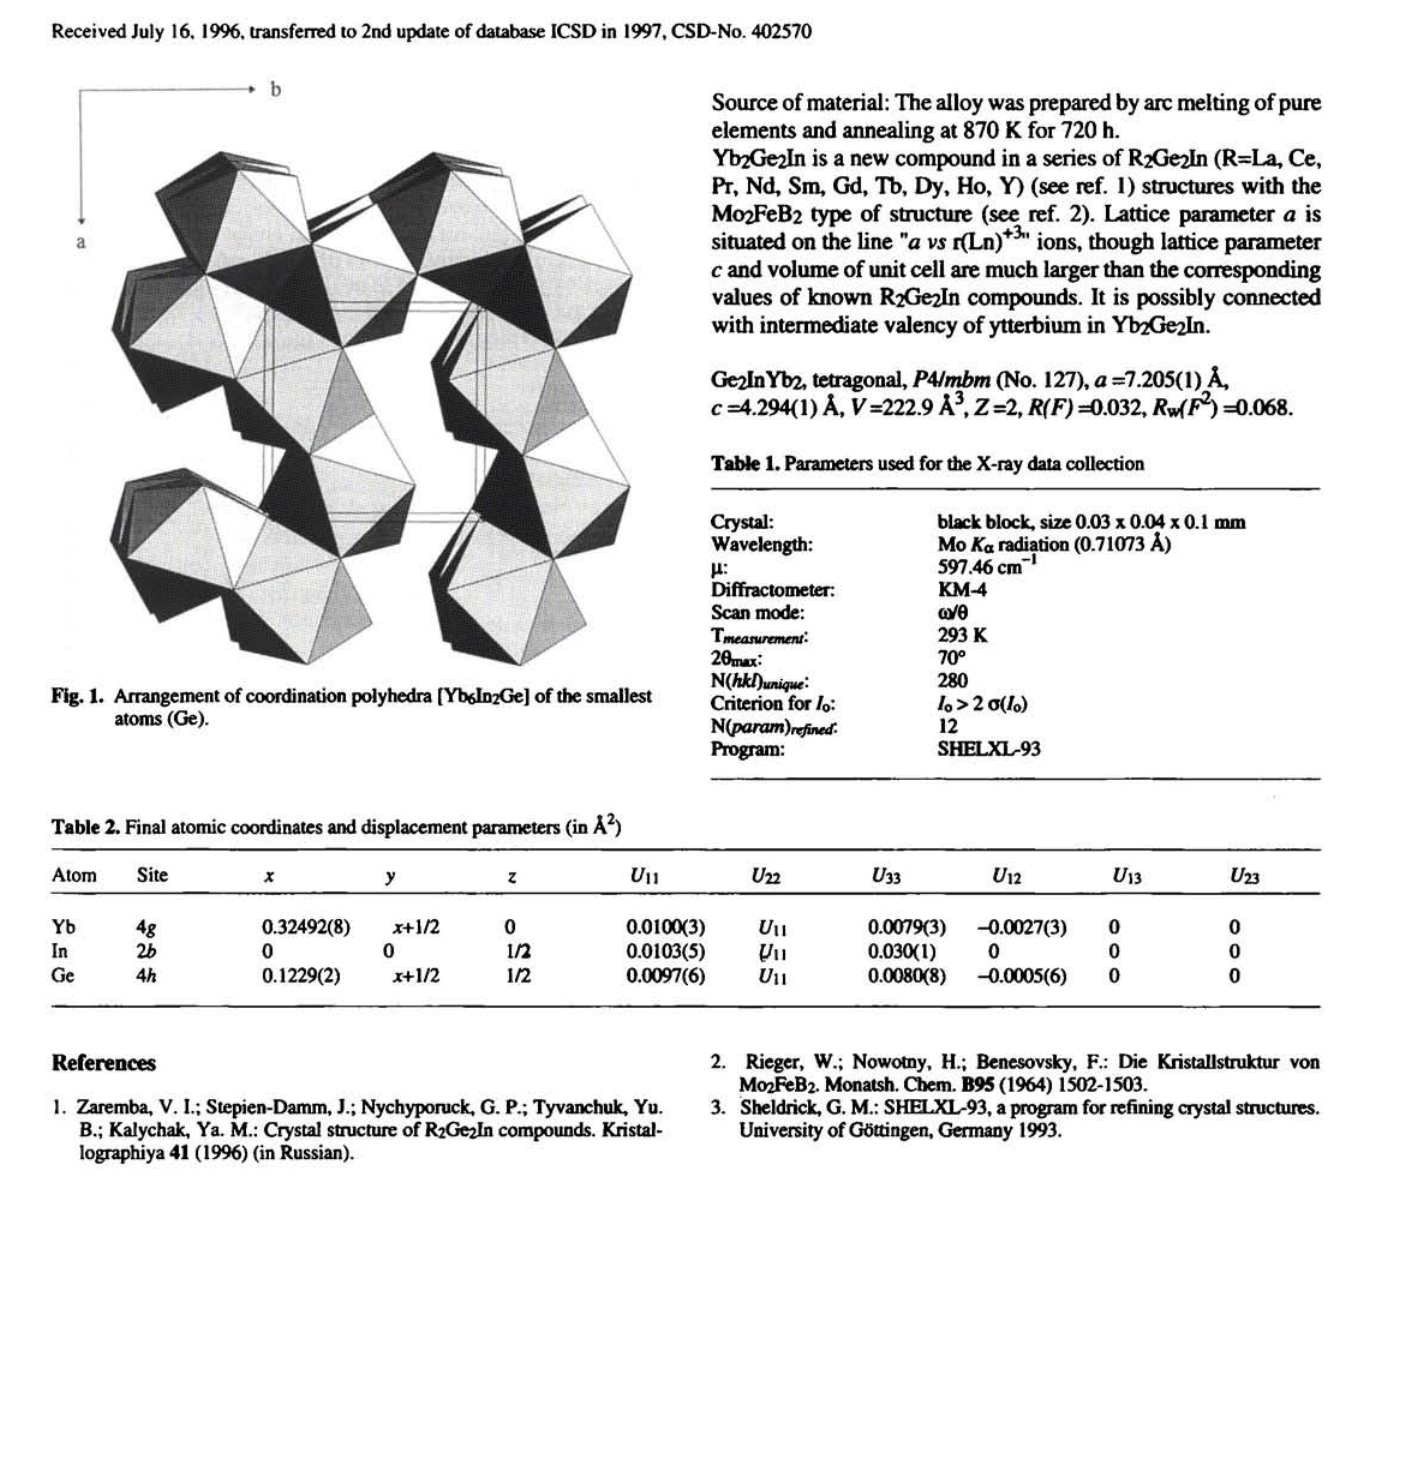
Fig. 1. Arrangement of coordination polyhedra [YbélnzGe] of the smallest atoms (Ge).